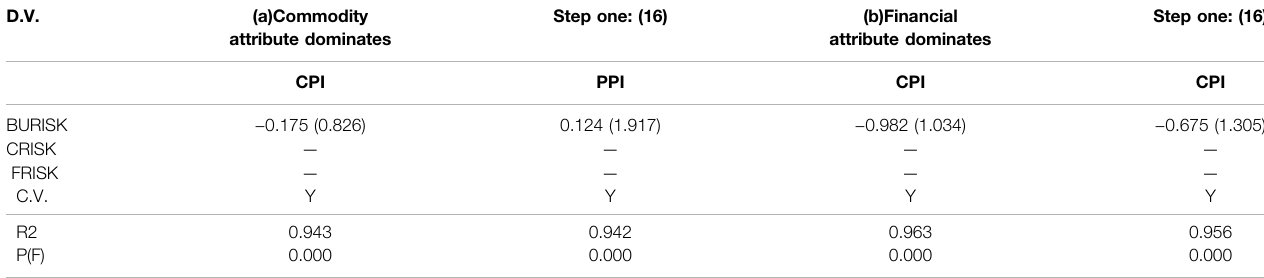
TABLE 8 | Test results on the spillover mechanism of international crude oil market upward returns risks when single oil attribute dominates.